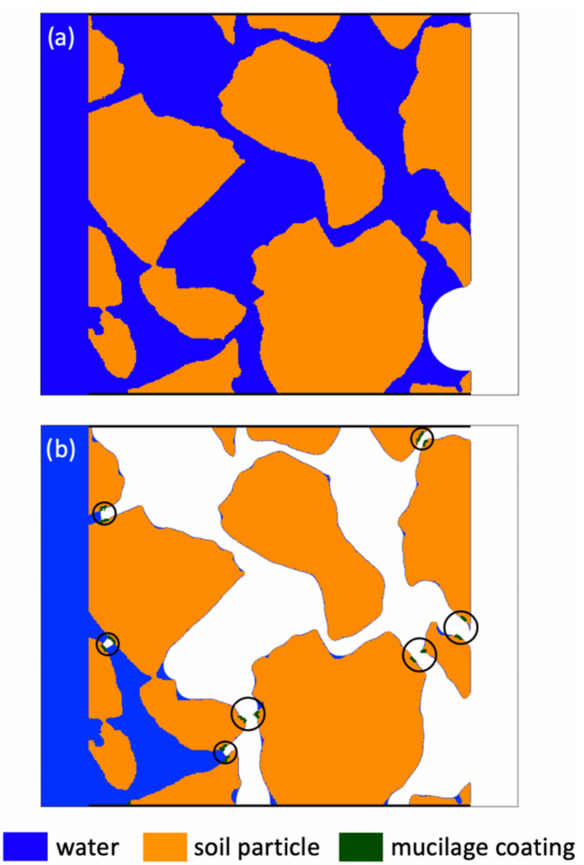
Figure 21. Soil system with ( a ) homogeneous CA = 20 is water conductive, while ( b ) with different CA (with mucilage: CA = 100 ◦ , without: CA = 20 ◦ ) is water repellent. Both images show infiltration after 11 ms, while in ( b ) the equilibrium state is present, which is already reached after 0.5